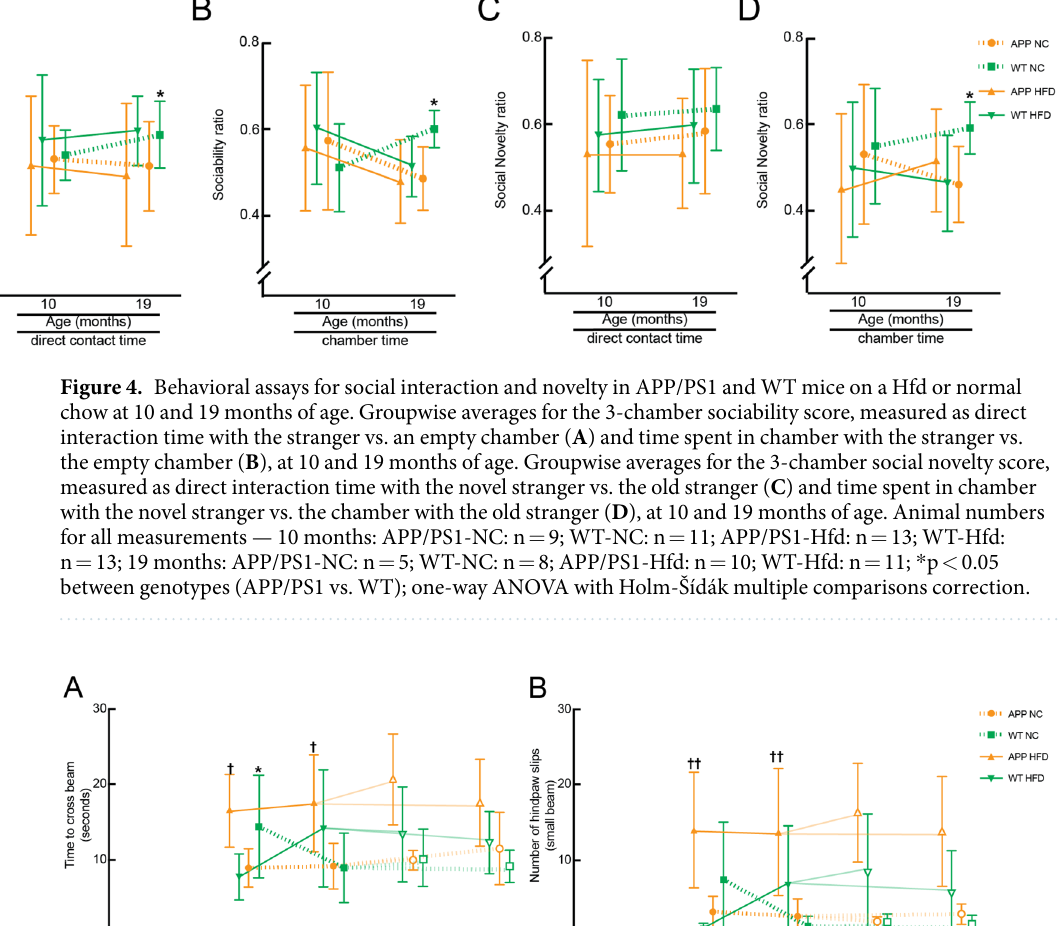
stalling in just a couple percent of cortical capillaries can cause flow decreases of ~20% 38 . Image stacks of the cortical capillary bed were taken using 2PEF microscopy across all four groups of mice (Fig. 6A–D) and ~96,000 individual capillary segments were scored as flowing or stalled (Fig. 6E). Consistent with our previous reports 38,39 , we found an increase in the fraction of capillaries with stalled blood flow in APP/PS1 mice as compared to WT, regardless of diet (percentage of capillaries stalled at 11 months (21 months) of age: APP/PS1-NC: 2% (1.1%); APP/PS1-Hfd: 1.7% (1.3%); WT-NC: 0.6% (0.3%); WT-Hfd: 0.5% (0.5%)). Consistent with our previous find- ings, these data show a decrease in the incidence of stalled capillaries with increasing age in the APP/PS1 mice. We observed no impact of diet on the incidence of stalled capillaries in either APP/PS1 or WT mice (Fig. 6F and Supplementary Fig. 7A). We distinguished different potential causes of stalled capillaries using an in vivo labeling strategy where leukocytes are labeled by both Rhodamine 6 G (mitochondria) and Hoechst (DNA), platelets are labeled by Rhodamine 6 G only, and RBCs are unlabeled and appear as dark patches in the fluorescently-labeled blood plasma (Texas Red-dextran) 38,47 . In the APP/PS1-NC mice, about 86% of the capillary stalls had a leuko- cyte in the stalled capillary segment, while 5% had platelets, and 9% had only RBCs. WT-NC mice not only had a lower total incidence of stalled capillaries, they also had different cellular compositions, with 0% containing leukocytes, 50% platelets, and 50% only RBCs. For mice on the Hfd, APP/PS1 animals had similar ratios to the